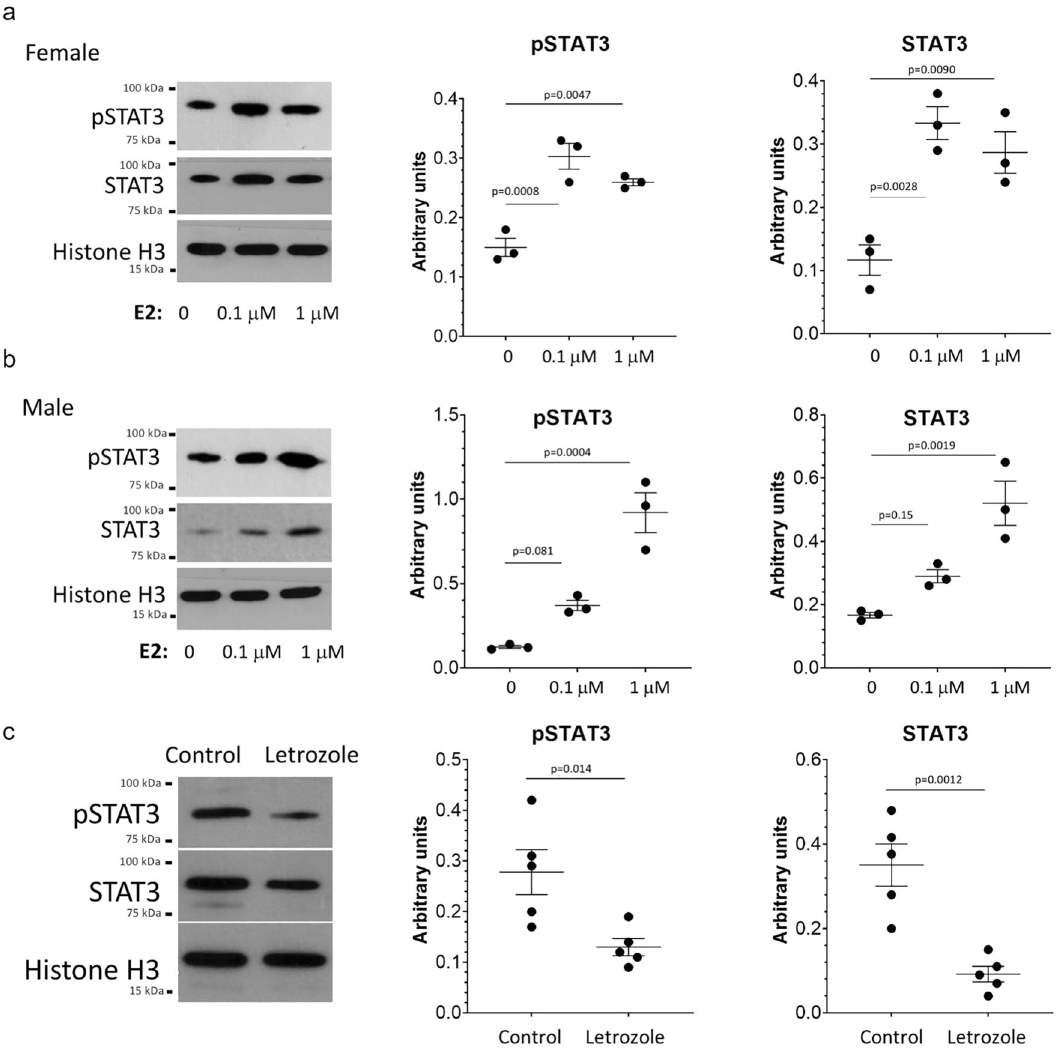
Fig. 10 Estrogen in fl uences Stat3 levels and activity in vitro and in vivo. Addition of estradiol (E2) to female ( a ) and male ( b ) pig chondrocytes resulted in dose-dependent increases in Stat3 levels and activity; female chondrocytes are dose-limited in their response to E2 as evidenced by similar induction at the 0.1 and 1.0 µ M doses. n = 3. c Intra-peritoneal Injection of Letrozole, an aromatase inhibitor that blocks the production of estrogen, reduced Stat3 levels and activity in female mouse sternal chondrocytes after 7 daily injections. n = 5 mice per